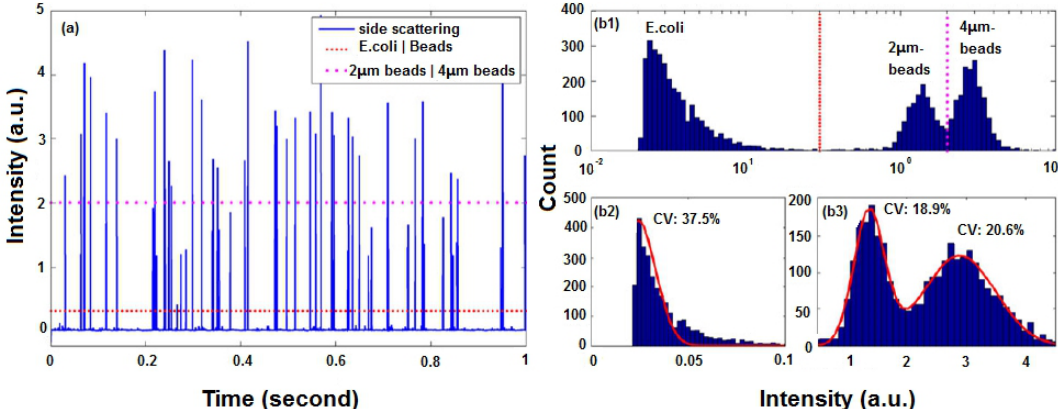
Figure 9. Data analysis results of a mixture of beads and cells flowing in an optofluidic microflow cytometer. ( a ) One second raw data of SSC signal intensity from a test with a mixture of E. coli cells and beads of 2 µm and 4 µm in diameter. ( b1 ) Statistical histograms of events by total beads and E. coli cells with intensity on a logarithmic scale. ( b2 ) Statistical histograms of events produced by E. coli cells on a linear scale and its Gaussian fitting. ( b3 ) Statistical histograms of events by beads with intensity on a linear scale and Gaussian fittings. Reprinted from [20] with permission from